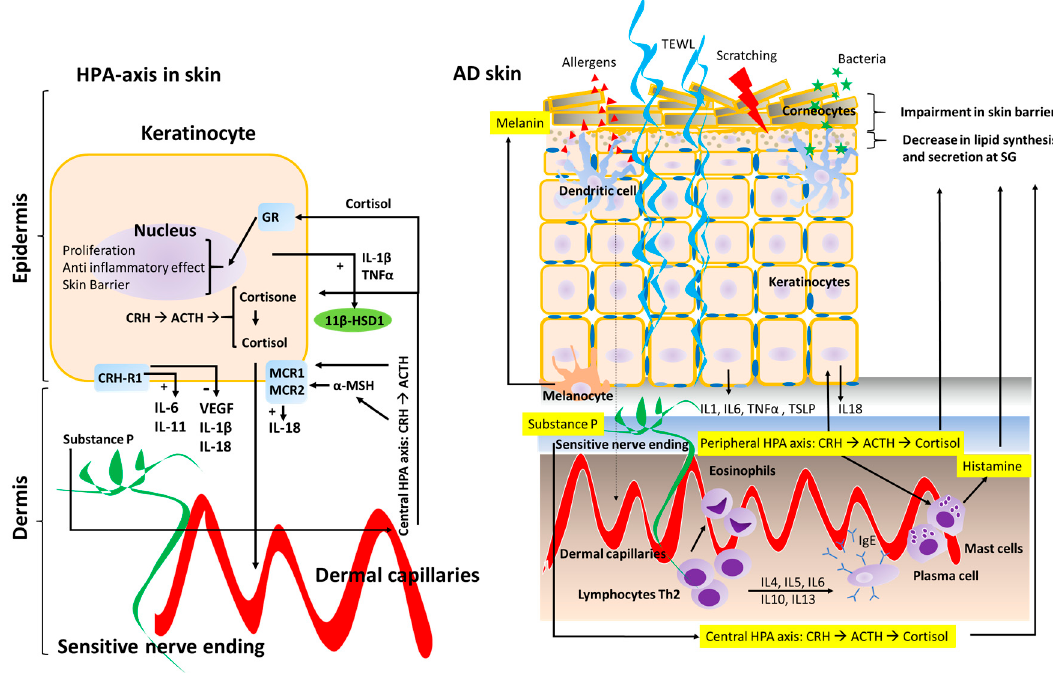
Figure 1. Schematic representation of the Hypothalamic-Pituitary-Adrenal (HPA) axis in the skin. The effects on keratinocytes (left diagram) on AD skin in regards to skin barrier structure and inflammatory response (right diagram). The central HPA axis and the peripheral HPA axis both regulate skin barrier homeostasis and the inflammatory response in the skin. Peripheral nerve endings in the skin are represented in green, whereas dermal capillaries are shown in red. Transepidermal water loss (TEWL) is represented by curled blue lines (right diagram). Corticotrophin-releasing hormone receptor type 1 (CRH-R1); Glucocorticoid receptor (GR); Melanocortin receptor type 1 and 2 (MCR1 and MCR2); 11 beta-hydroxysteroid dehydrogenase 1 (11 β -HSD1).